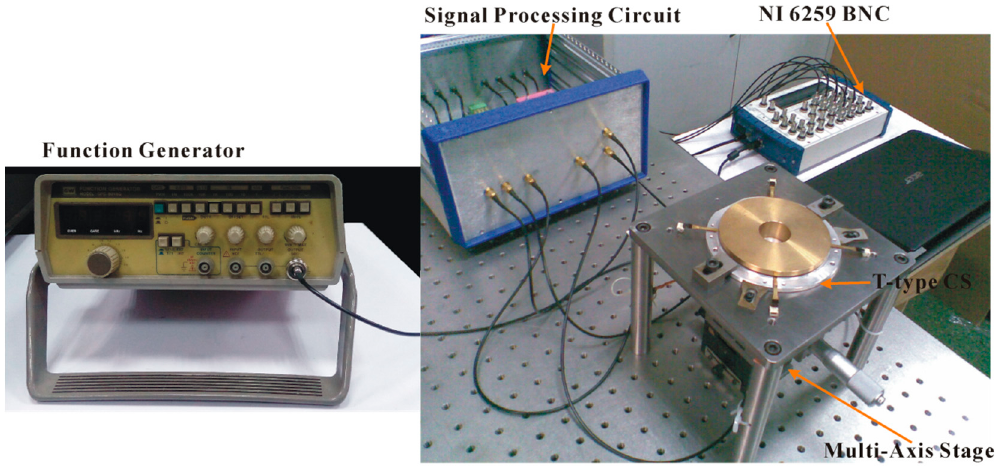
Figure 18. Experimental test system.